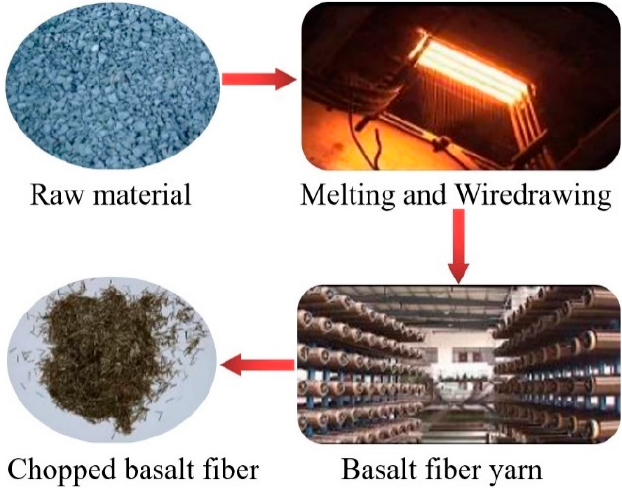
Figure 1. Preparation process of basalt fiber.